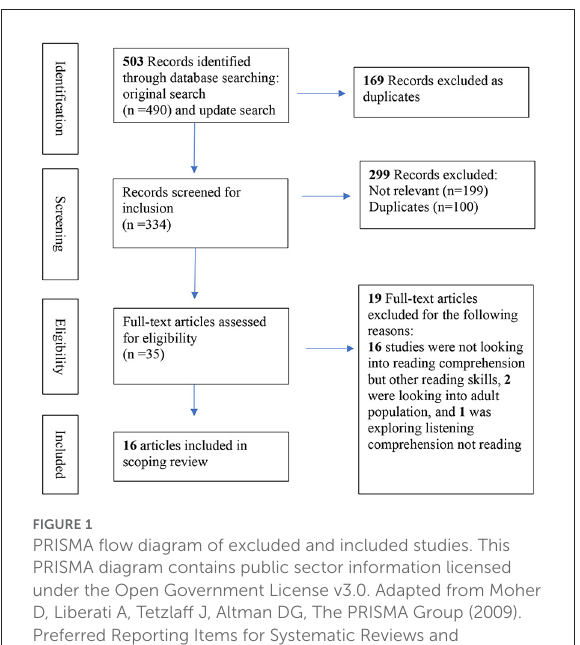
FIGURE1 PRISMA flow diagram of excluded and included studies. This PRISMA diagram contains public sector information licensed under the Open Government License v3.0. Adapted from Moher D, Liberati A, Tetzlaff J, Altman DG, The PRISMA Group (2009). Preferred Reporting Items for Systematic Reviews and Meta-Analyses: The PRISMA Statement. PLoS Med 6(6): e1000097.